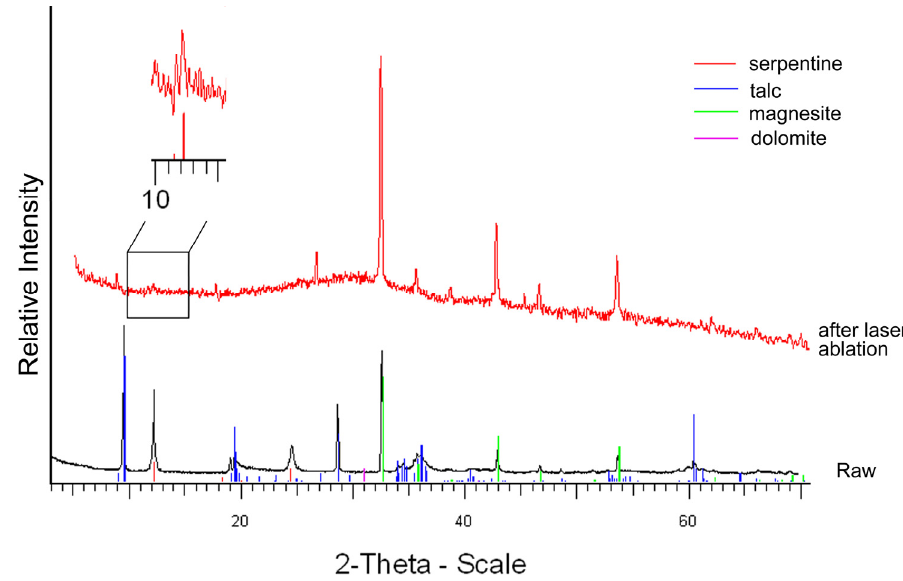
Figure 8. Study under the microscope of powder obtained after laser ablation. ( a ) Mask retrieved from the laser equipment; ( b ) mask under the microscope; ( c ) clean mask under the microscope—the original texture of the mask is shown here; ( d ) mask with the retained powder after laser ablation—only a mass of talc is seen in this picture.